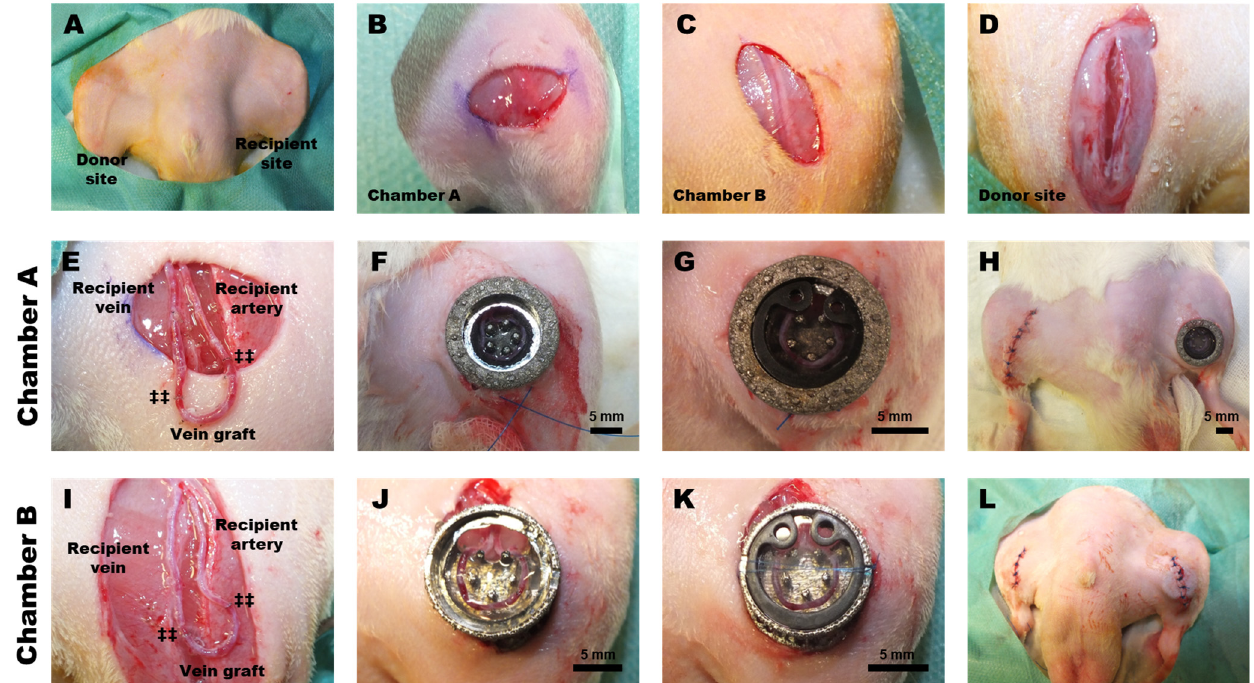
Figure 2. AV loop preparation. ( A ) Shaving and disinfection of the donor as well as recipient sites. ( B ) For chamber A surgical preparation, a small horizontal incision is applied to open the skin. ( C ) For chamber B the skin is opened by a vertical incision. ( D ) Next, the donor femoral vein is exposed and carefully separated. ( E ) AV loop preparation for chamber A. ( F ) After positioning a loop in chamber A (partially filled with GelMA), the skin is retained in the grove, and the chamber is fastened to the skin using a purse string fixing technique. ( G ) Placement of the glass window with a snap ring and chamber installation. ( H ) Top view of the surgical site following the AV loop procedure. ( I ) AV loop preparation for chamber B. ( J ) Placement of the loop in the partially GelMA-filled chamber B. ( K ) Placement of the glass window. ( L ) Top view of the surgical site after subcutaneous installation of chamber B. ‡‡: microsurgical anastomosis; scale bar: 5 mm.